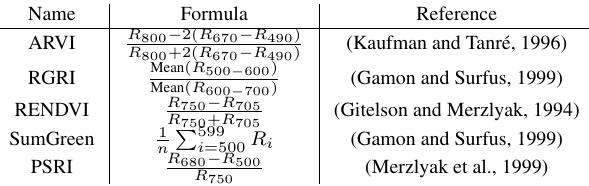
Table 1: The selected VIs included in the barley data set ordered descending by their ReliefF